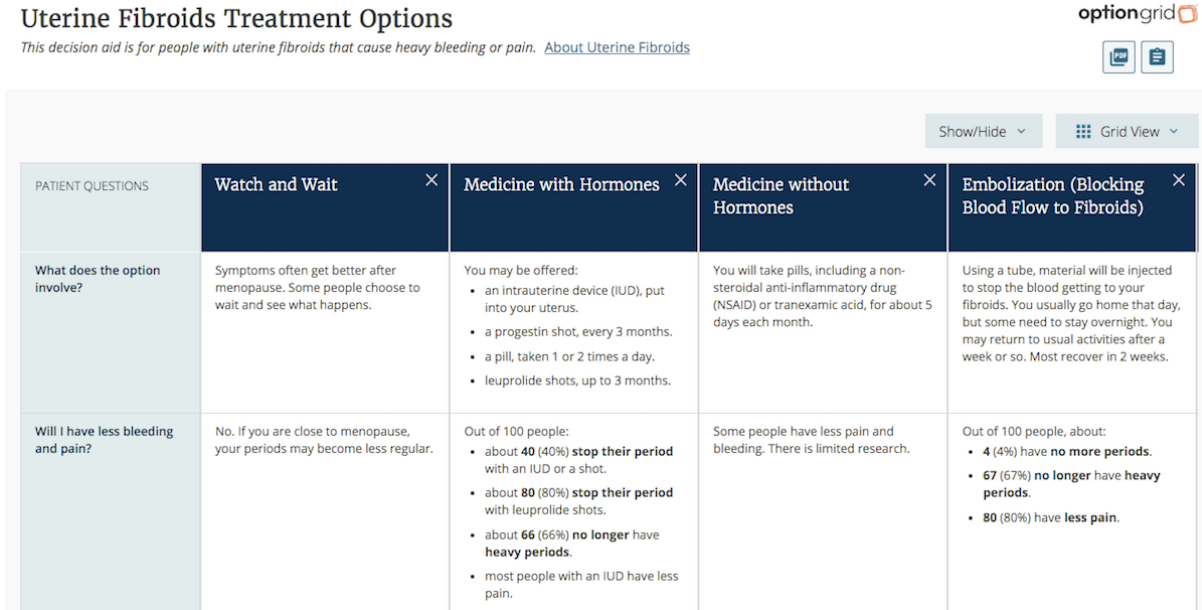
Figure 1. Snapshot of the text version of the uterine fibroid Option Grid patient decision